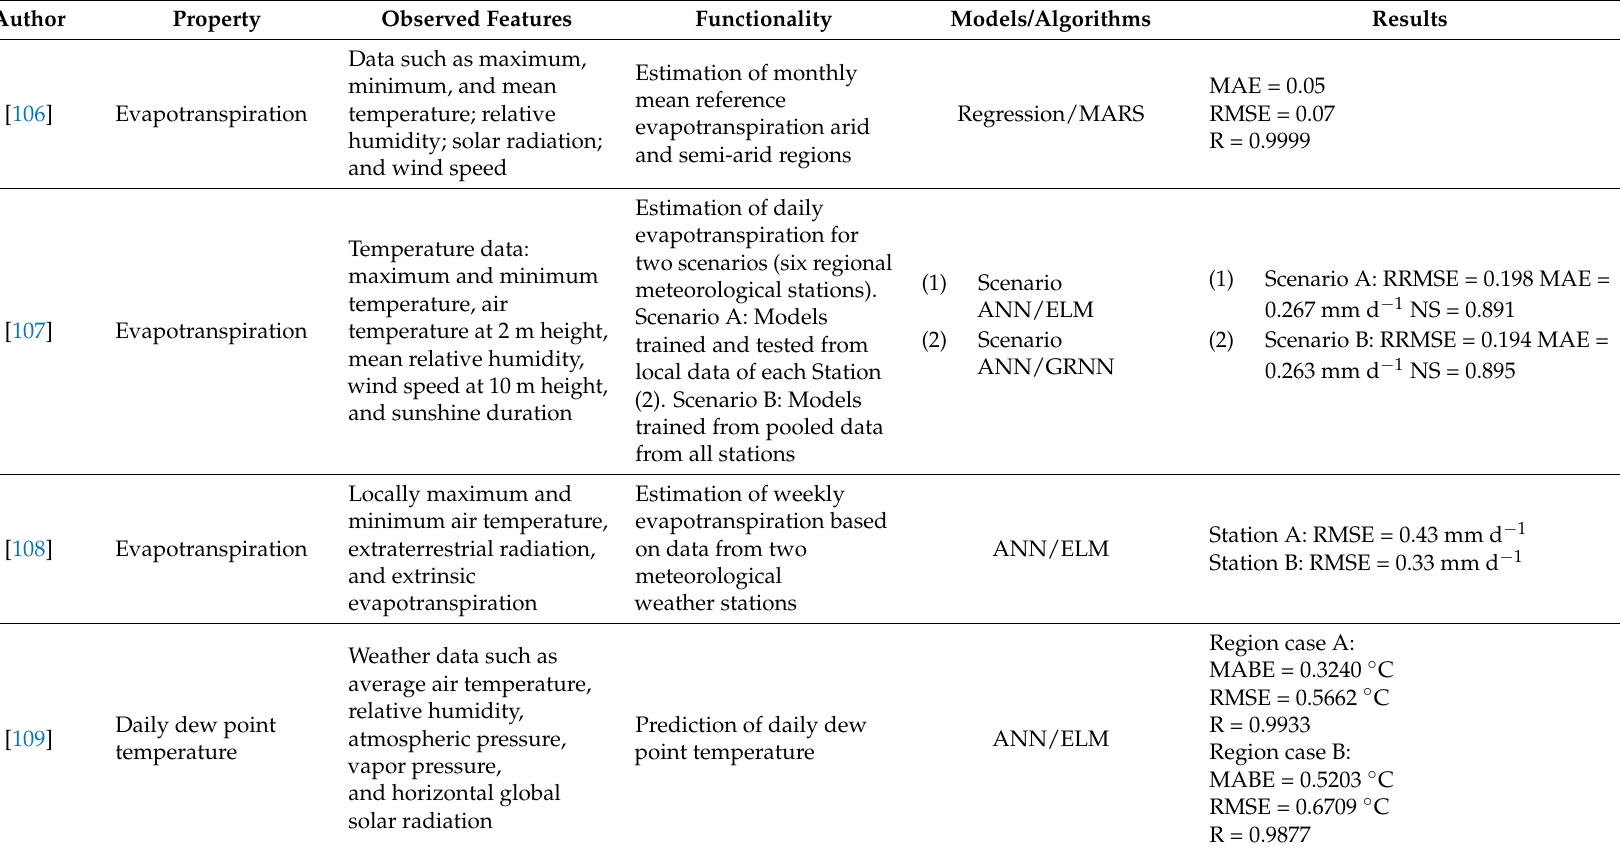
Table 12. Water: Water management